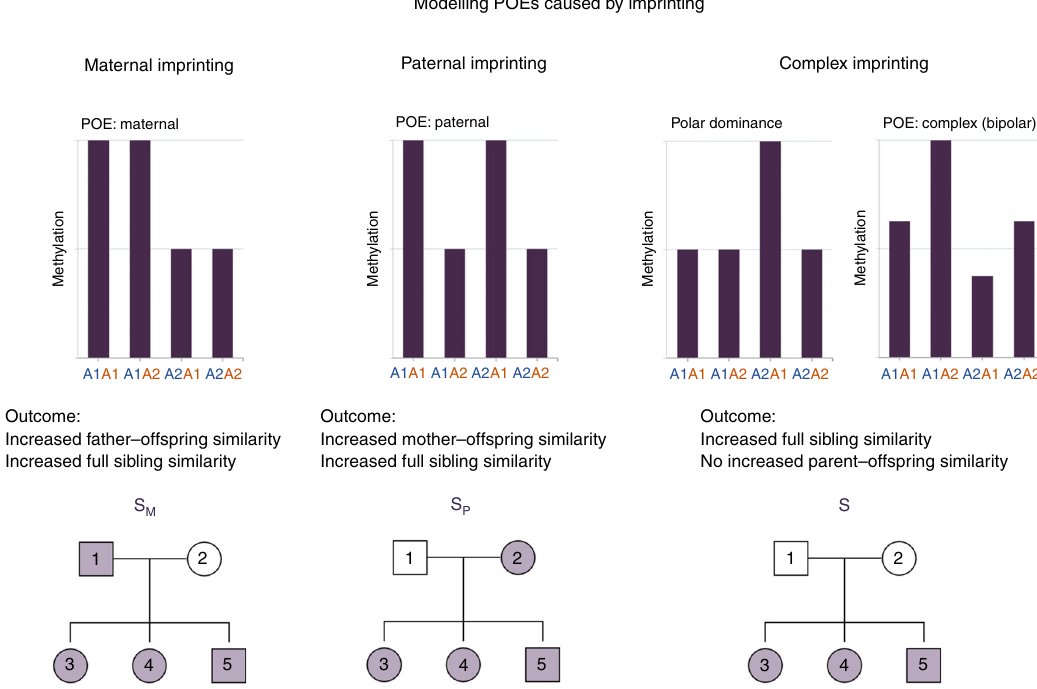
Fig. 1 The expected phenotypic covariance structures between nuclear family members introduced by different POE patterns. The bar charts show putative levels of methylation associated with the four possible genotypes at a SNP controlling imprinting (paternal allele in blue, maternal allele in red). The family pedigrees show as shaded the family members between which similarity in methylation is increased due to these patterns of